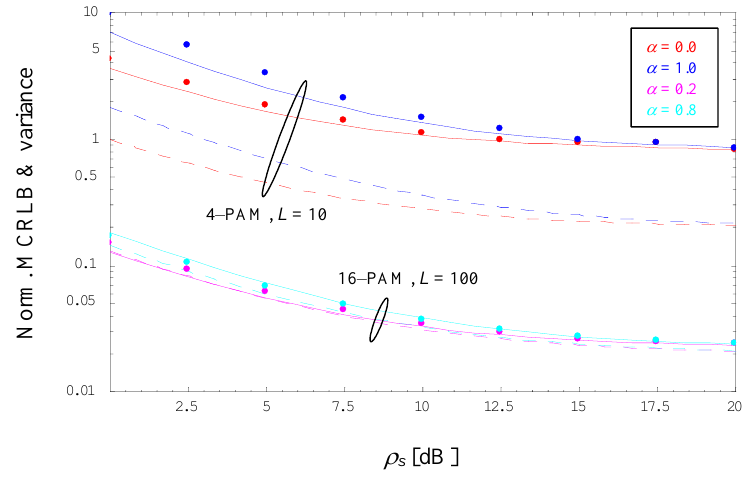
Figure 3. Evolution of the normalized MCRLB and variance.